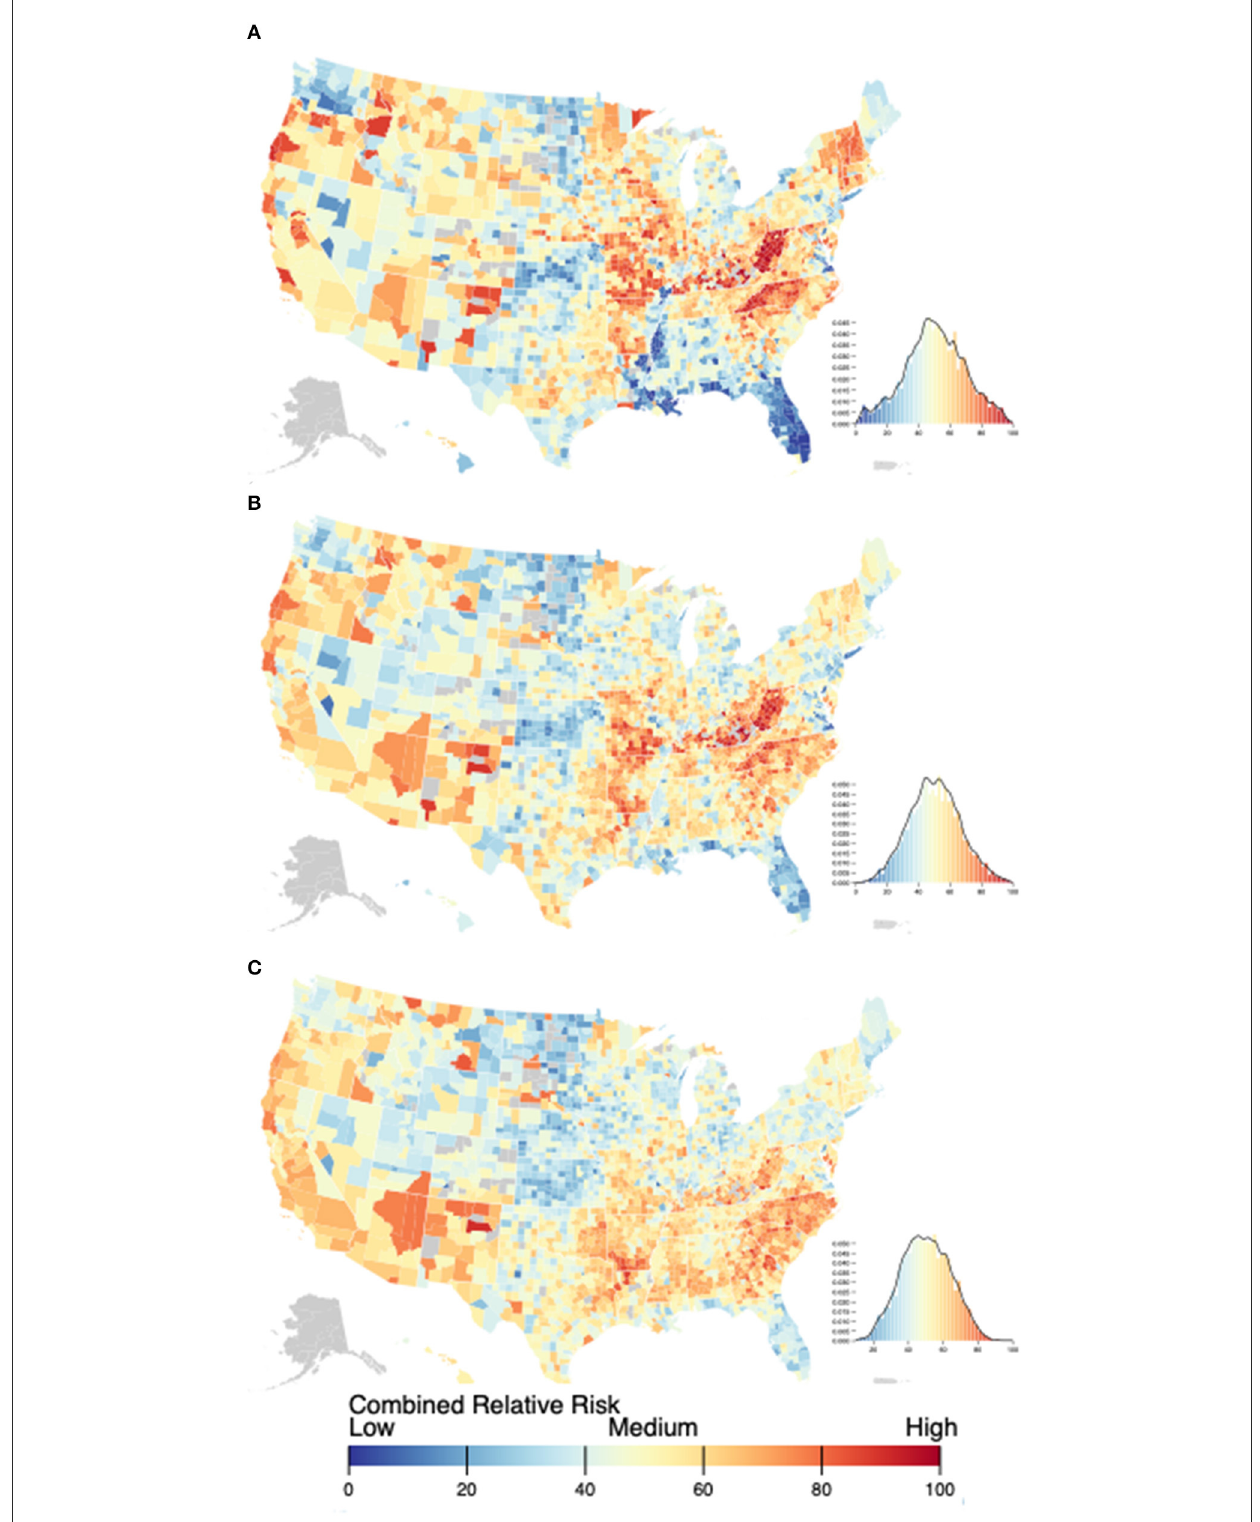
FIGURE6 As in Figure 3, but highlighting the contrast between combinatory landscapes of: (A) aggregate flood risk and water quality risk; (B) aggregate flood risk, water quality risk, and population below the poverty level; and (C) aggregate flood risk, water quality risk, population below the poverty level, and non-white